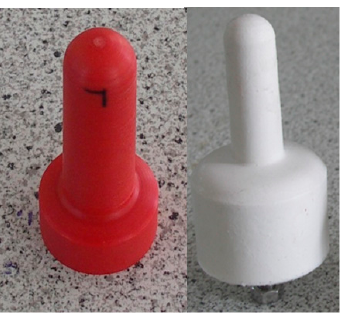
Figure 1. The plastic teat ( left ) and the silicone teat ( right ) used in this investigation.